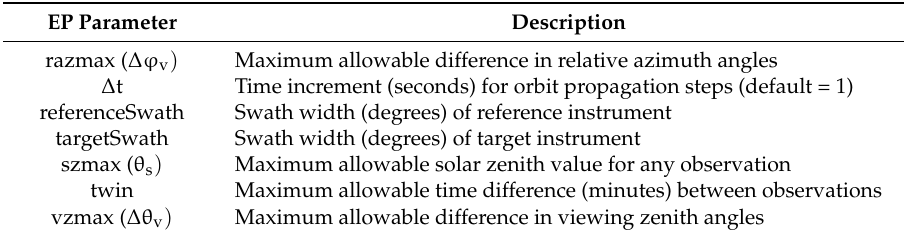
Table 2. User-specified LEO-LEO event prediction parameters.